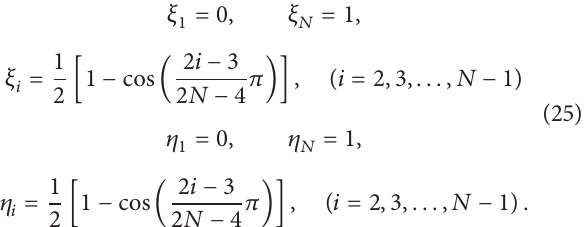
𝑁 = 𝑀 . The distribution forms of the grid points are nonuniform; the distribution forms of the grid points